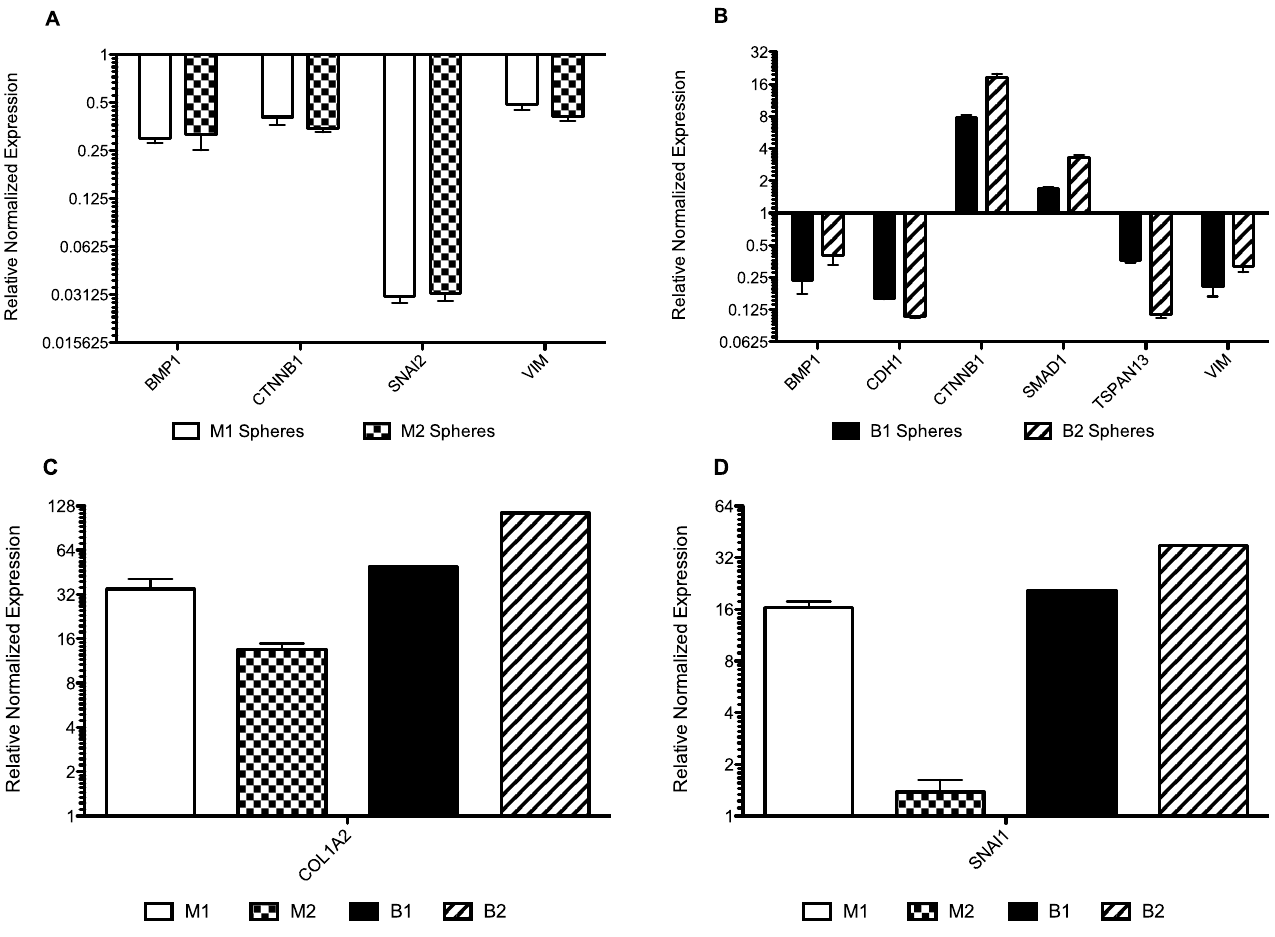
Fig 6. (A) Gene expression from quantitative RT-PCR results of M1 and M2 spheres compared to their respective adherent cells. BMP1, CTNNB1, SNAI2, and VIM were downregulated, while COL1A2 upregulated in both clones. (B) Gene expression results from quantitative RT-PCR results of B1 and B2 spheres compared to their respective adherent cells. COL1A2, CTNNB1, SMAD1, and SNAI1 are significantly upregulated in spheres, while BMP1, CDH1, TSPAN13, and VIM are significantly downregulated. Expression of COL1A2 (C) and SNAI1 (D) were plotted alone for clarity due to the large scale of the increase. SNAI1 was not significantly upregulated in clone